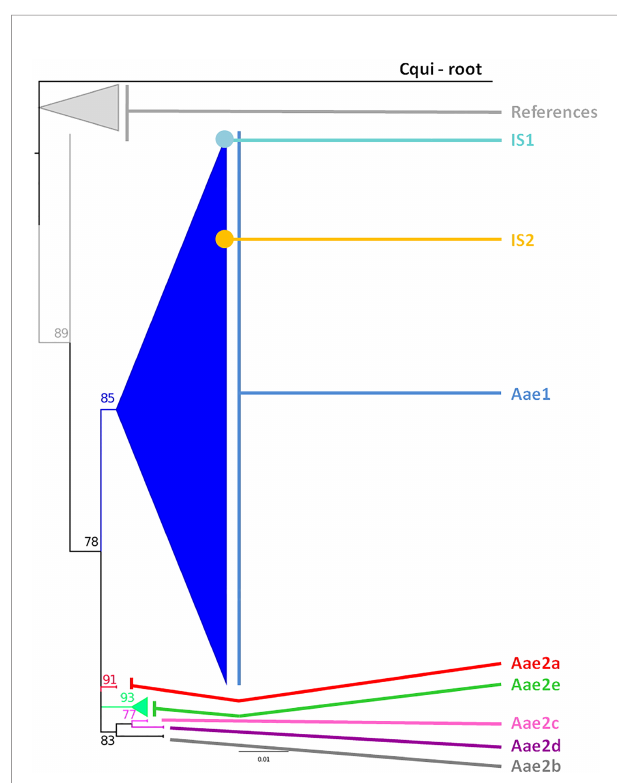
FIGURE 2 | Phylogeny of the Aedes aegypti cox 1 gene. The phylogenetic trees were built using maximum-likelihood (ML) with the general time reversible model with gama distributed with four discrete categories (GTR + I + G). The clade support was assessed via 500 bootstrap replicates. The tree was rooted using the Culex quinquefasciatus cox 1 gene (MK265737) as outgroup. The color code is that of the cox 1 subclusters shown in Supplementary Table 1 : light gray: References, dark blue: Subcluster Aae1, red: Subcluster Aae2a, dark gray: Subcluster Aae2b, pink: Subcluster Aae2c, purple: Subcluster Aae2d, green: Subcluster Aae2e, light blue: individual sample 1, yellow: individual sample 2, black: root. “ References ” correspond to the Ae. aegypti cox 1 sequences published by Yohan et al. (2018) from samples collected in 2013 whose accession numbers are KP334259 to KP334269 and KP869121 to